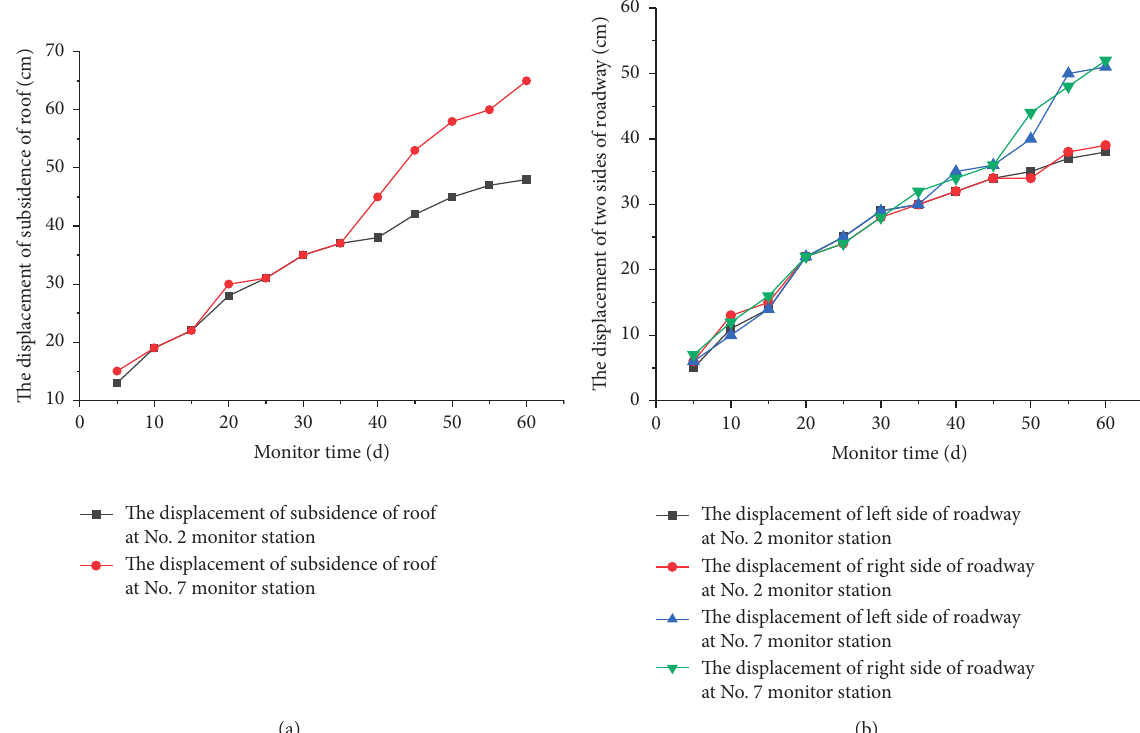
Figure 10: Displacement of surrounding rock of haulage roadway: (a) the subsidence of the roof; (b) the lateral displacements of the roadway.